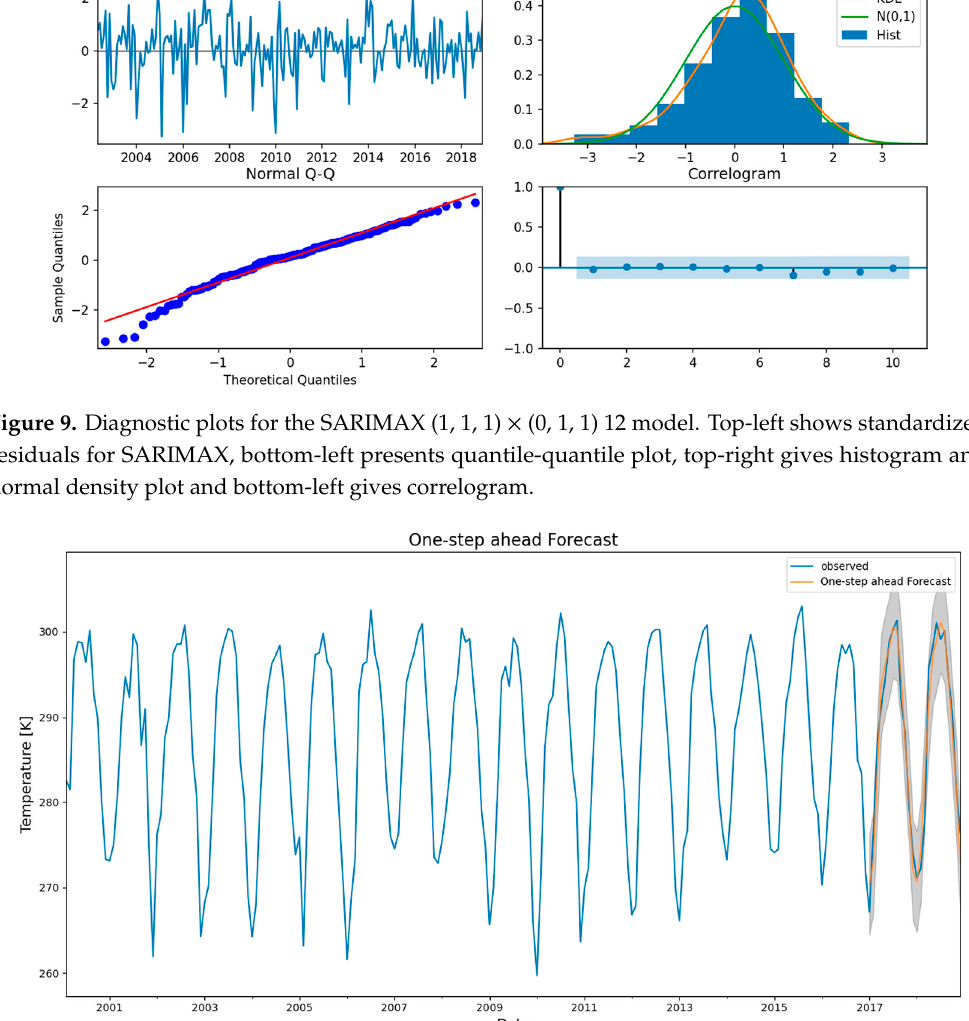
Figure 10. Modeled temperature (2017–2019) along with the measured data.